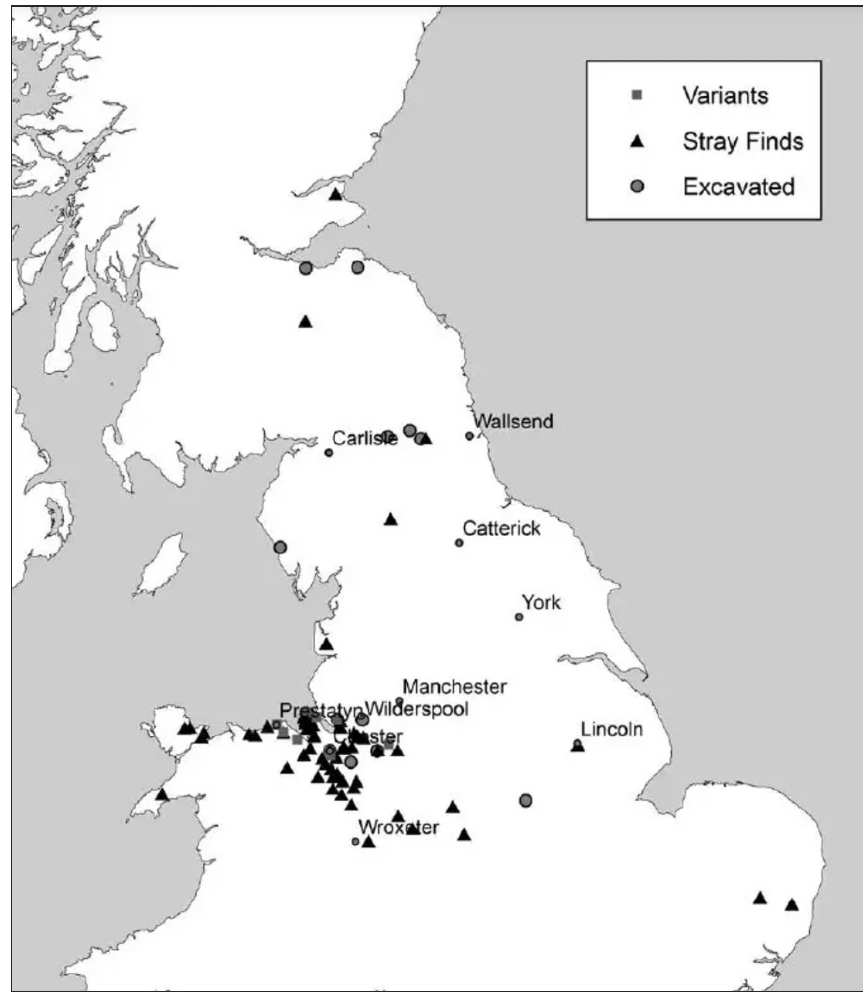
Figure 7: Distribution of Wirral type brooches and variants (Philpott 1999: 281. Reproduced with